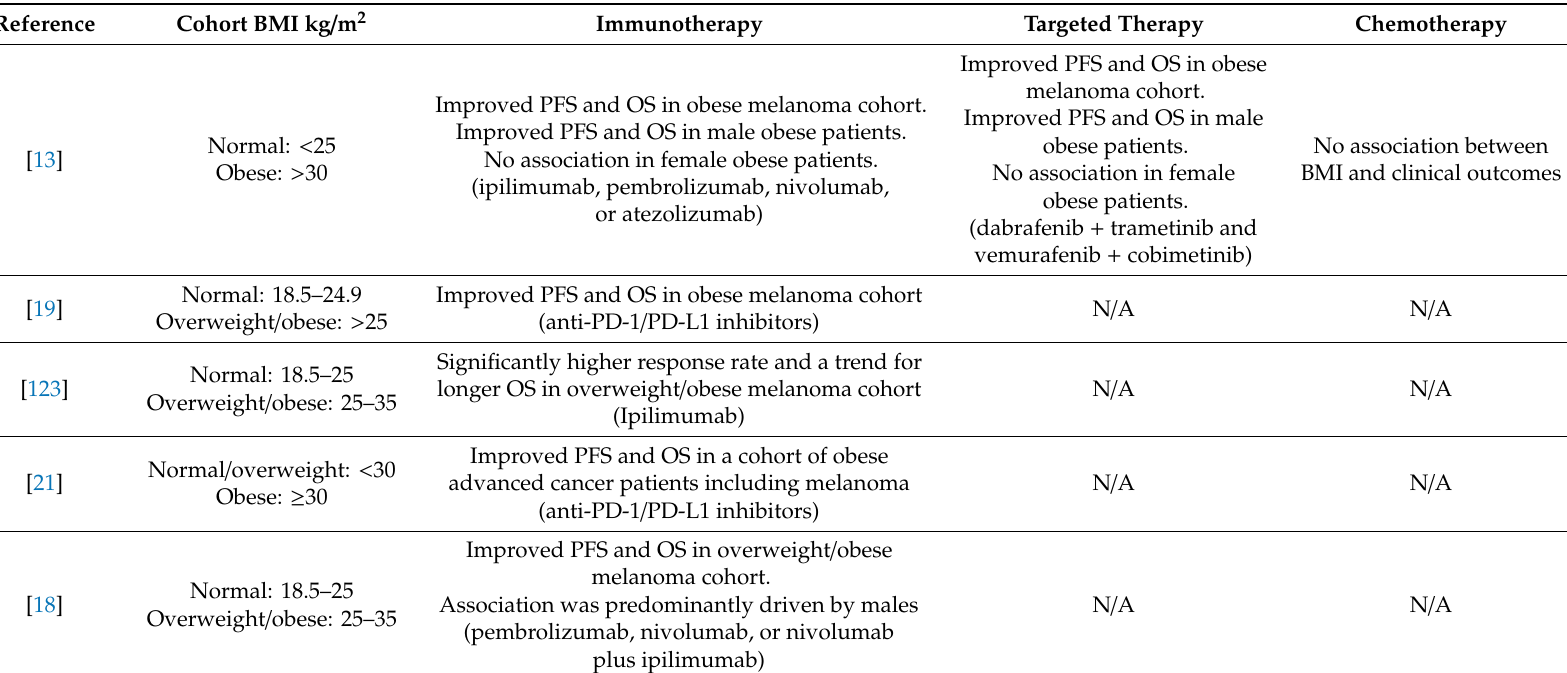
Table 1. The association of high body mass index with melanoma